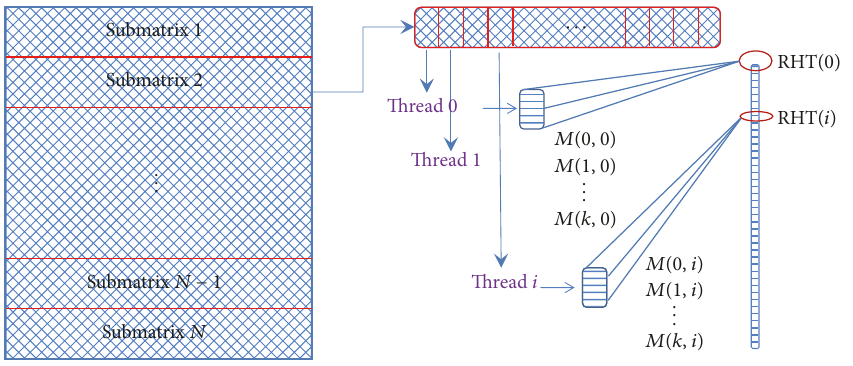
Figure 5: Flowchart of matrix partition for threads